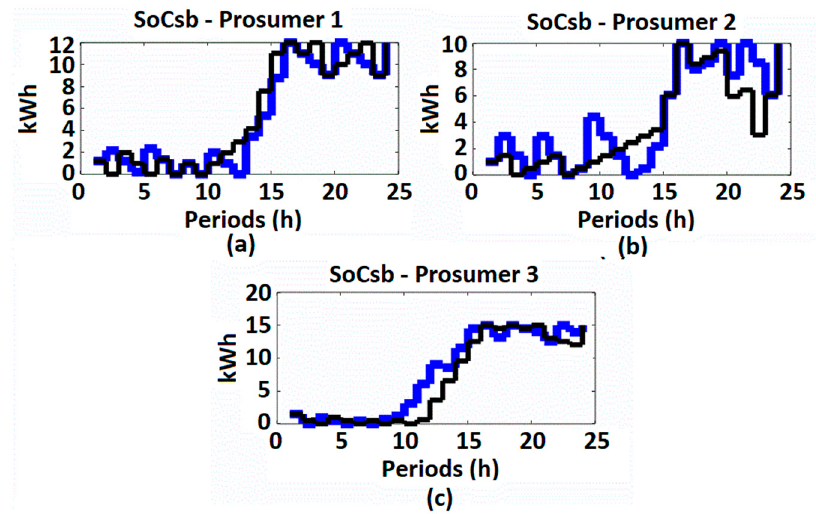
Figure 8. State of charge SoC sb of SBs for Case 1 (in blue) and Case 2 (in black) related to ( a ) prosumer 1; ( b ) prosumer 2; and ( c ) prosumer 3